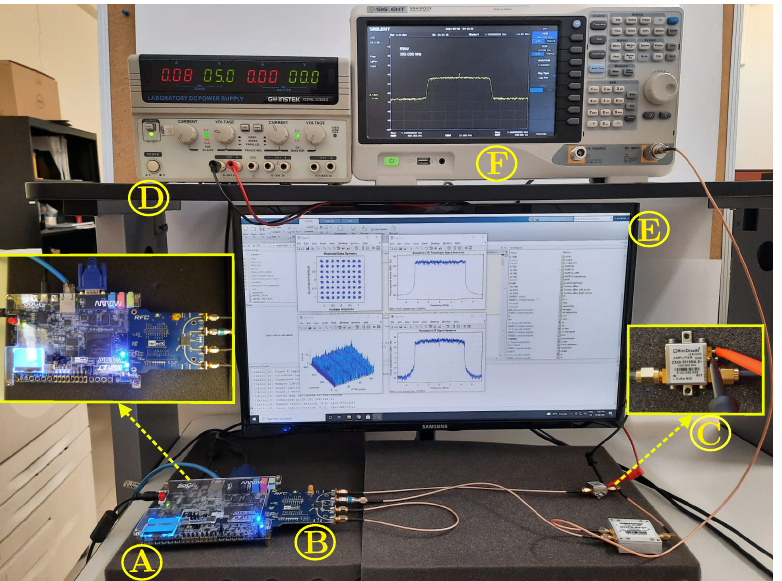
Figure 5. Experimental testbed photograph. Relevant instruments depicted as follows. ( A ): Altera Cyclone V FPGA SoC-Kit. ( B ): AD9361 RF Agile Transceiver working at 2.40 GHz center frequency. ( C ): High isolation amplifier Mini-Circuits ZX60-5916MA+. ( D ): Power Supply GW INSTEK